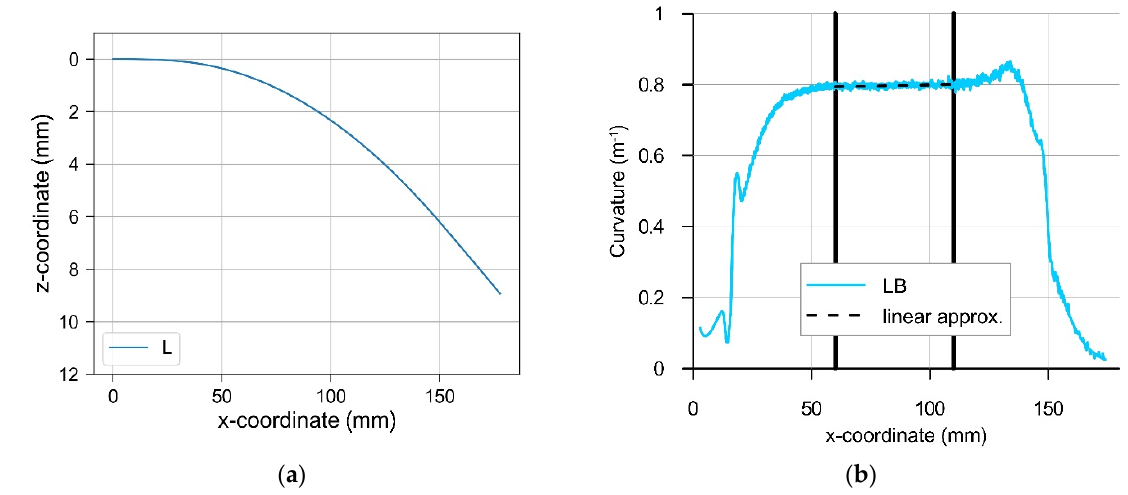
Figure 11. Final configuration ( a ) and curvature ( b ) of the axis of the beam due to the pure laser bending (load case LB, calculation step L).